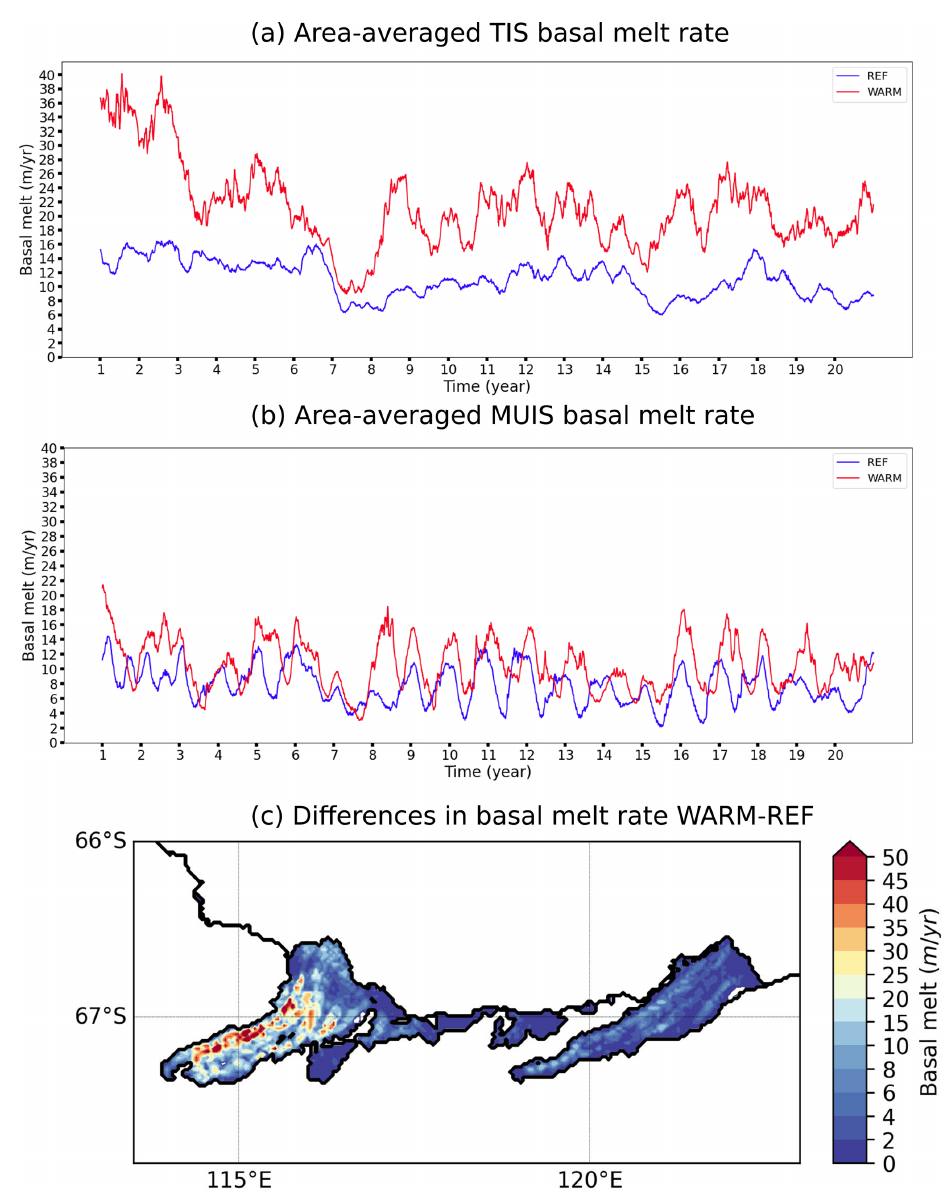
Figure 10. Time series of the area-averaged TIS (a) and MUIS (b) basal melt rates from the REF (blue) and WARM (red) simulations. Spatial distribution of the differences in ice shelf basal melt rate between the REF and WARM simulations. The time periods are 1995–2014 for REF and 2081–2100 for WARM. The mean TIS basal melt rate is 11 . 13 ± 2 . 54myr − 1 in REF and 21 . 29 ± 5 . 88myr − 1 in WARM, while the MUIS basal melt rate is 7 . 73 ± 2 . 51myr − 1 in REF and 10 . 51 ± 3 . 35myr − 1 in